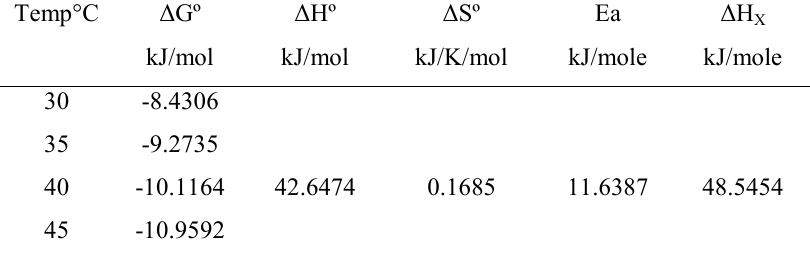
Table 4. Thermodynamic Parameters at different